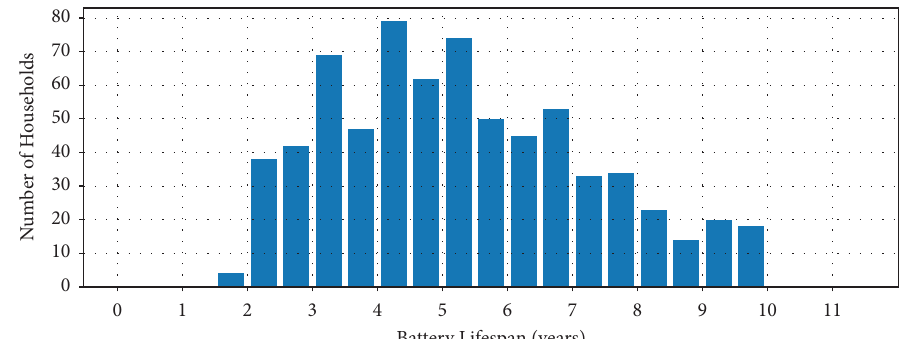
Figure 7: Useable battery lifespan distribution.